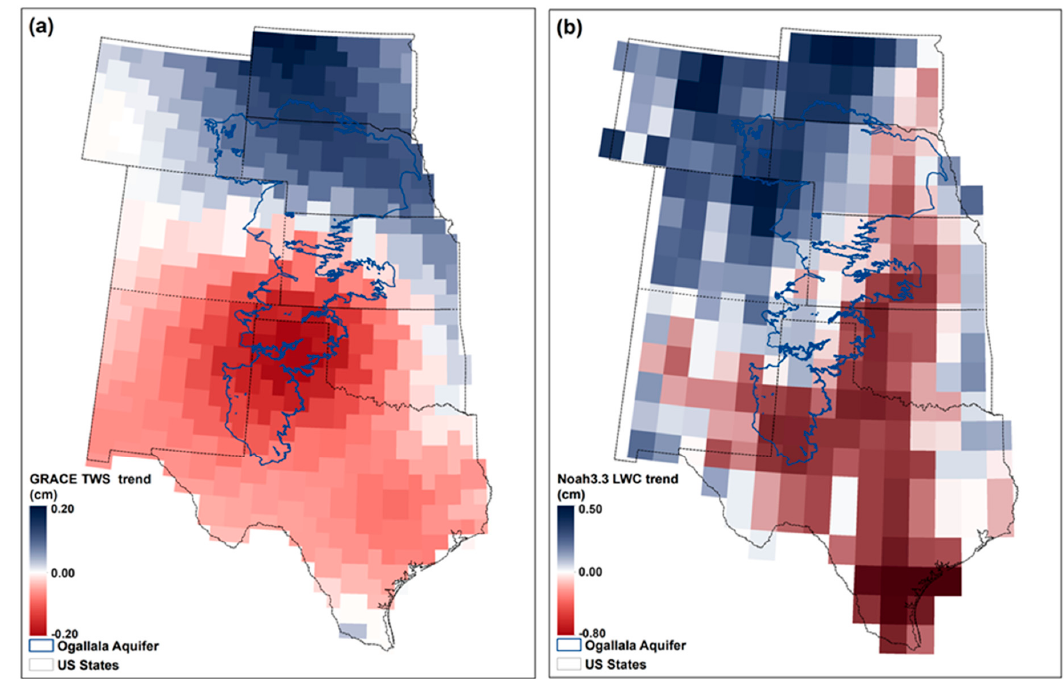
Figure 6. Mean annual total water storage (TWS). GRACE observations for the period 2002 to 2017 ( a ) and GRACE-FO observation for the period 2018–2019 ( b ).